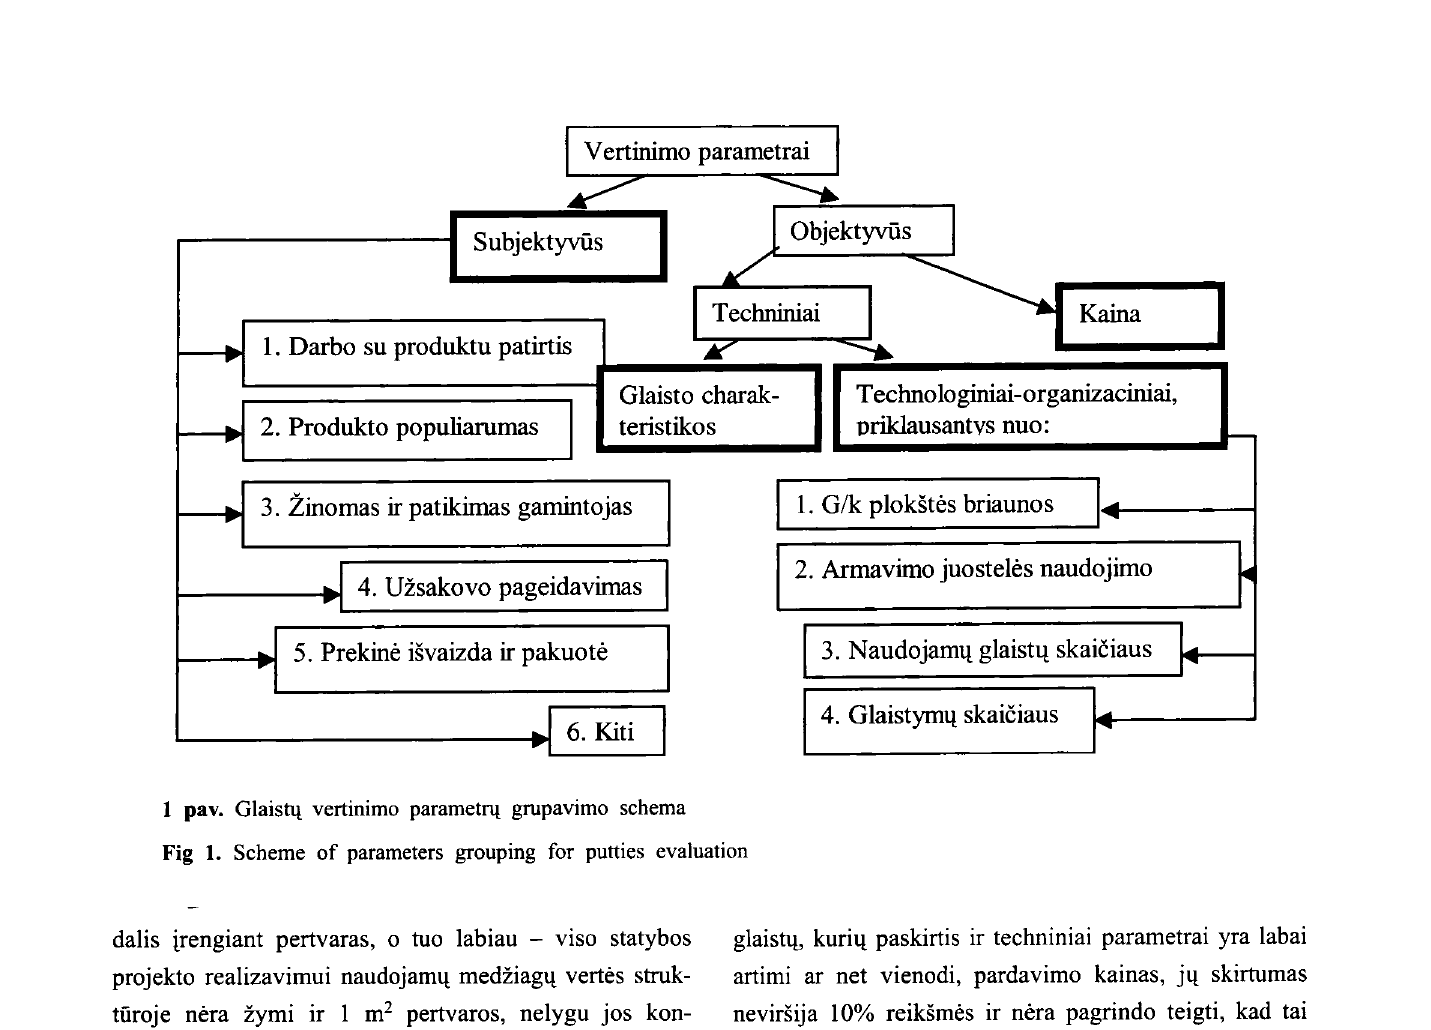
dalis irengiant pertvaras, o tuo labiau - viso statybos projekto realizavimui naudojamq medziagq vertes struk tiiroje nera zymi ir 1 m 2 pertvaros, nelygu jos kon strukcija, svyruoja apie 5%-7%. Ji ir absoliuciuoju